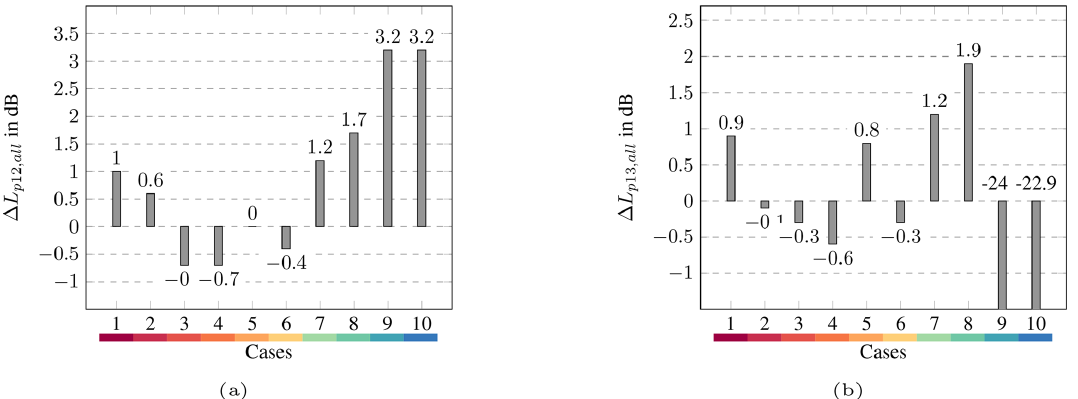
Figure 9. Difference of measured and modelled overall propagation losses between (a) Mic 1 (178m) and Mic 2 (535m) and between (b) Mic 1 (178m) and Mic 3